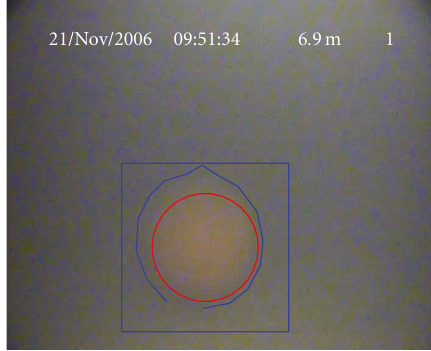
Figure 12: Segmentation of a mine at sea. C good = 0 . 66 and C false = 0 . 005.